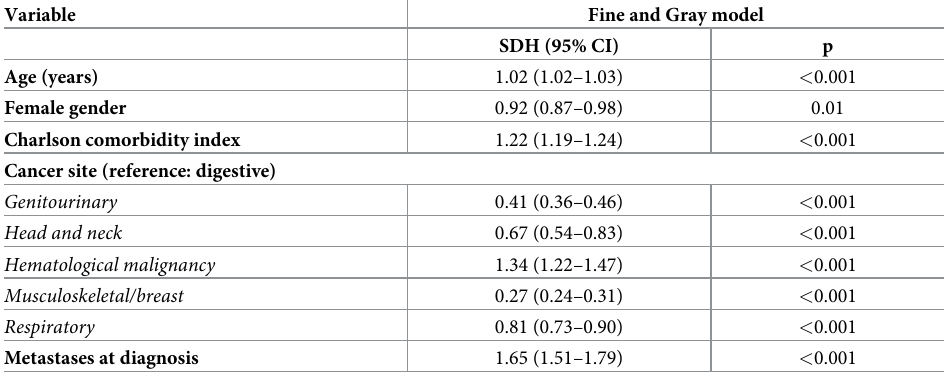
Table 3. Effect of baseline characteristics on the subdistribution hazard (SDH) of sepsis within 1 year after cancer diagnosis, based on a competing risk model with death without sepsis treated as the competing